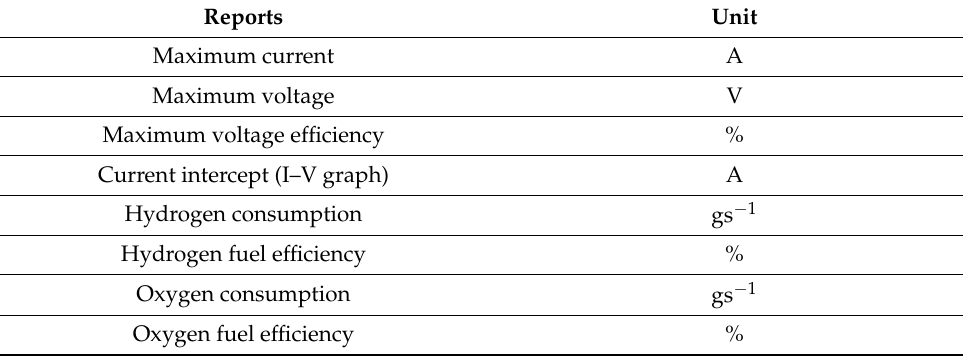
Table 2. Experimental investigation reports